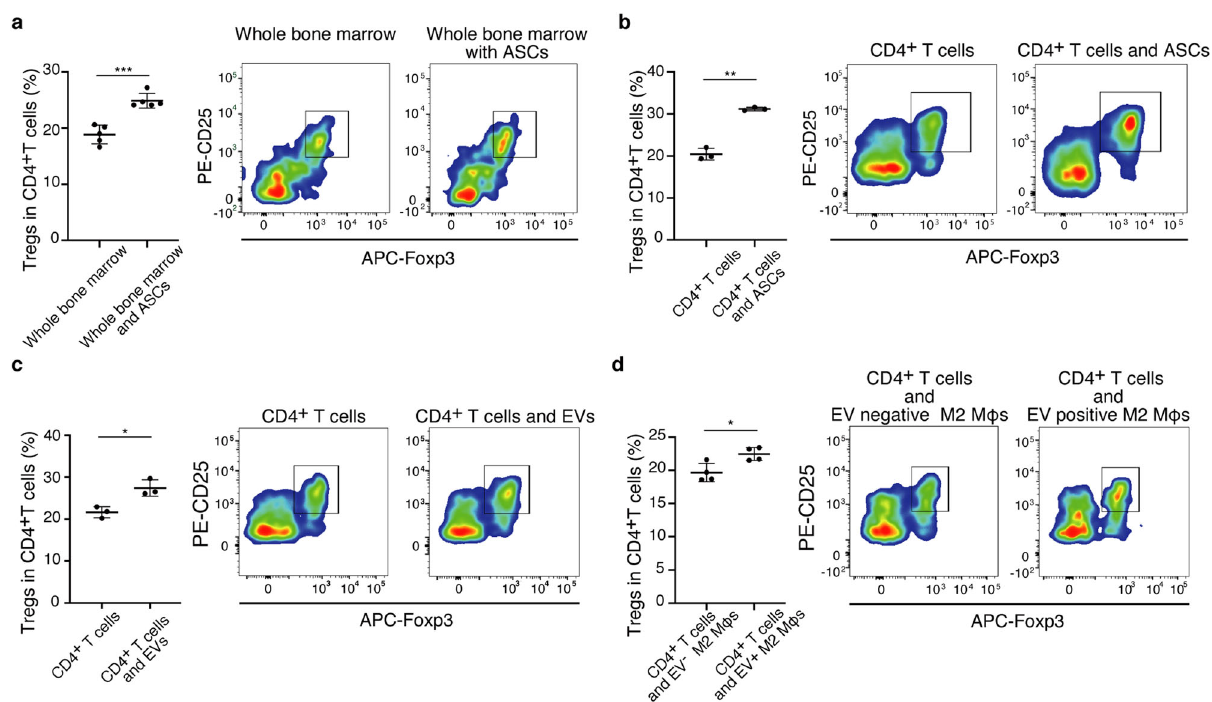
Fig. 8 EVs and EV-transferred M2 macrophages can induce Tregs in vitro. a The co-culture of whole bone marrow cells and ASCs. ASCs enhanced Treg induction in CD4 + T cells ( n = 5 per group). b The co-culture of CD4 + T cells sorted from bone marrow and ASCs ( n = 3 per group), c the co-culture of CD4 + T cells sorted from bone marrow and EVs derived from cultured ASCs ( n = 3 per group), and d the co-culture of CD4 + T cells sorted from bone marrow and M2 macrophages with EVs ( n = 4 per group) induced Tregs in CD4 + T cells. All data are shown as means ± SD. * p ≤ 0.05, ** p ≤ 0.01, and ** p ≤ 0.001 as determined by Welch ’ s t labeled monoclonal antibodies listed in Supplementary Table 3, B – D. Leukocyte subsets were gated as shown in Fig. S2, and analyzed using FlowJo software (v10) (BD Bioscience, Tokyo, Japan). For fl ow cytometric sorting, cells were sorted using a FACS SORP Aria II (BD Bioscience, Tokyo, Japan). Cytospin4 Cytocentrifuge (Thermo Fisher Scienti fi c, MA, USA) was used to observe the sorted cells under the microscope. For quantitative RT-PCR analysis and RNA-Seq analysis, cells were sorted using a FACS SORP Aria II after isolating cells with biotin anti-rat CD11b/c antibody (Biolegend, San Diego, CA, USA) and Streptavidin Particles Plus (BD, San Jose, CA, USA).